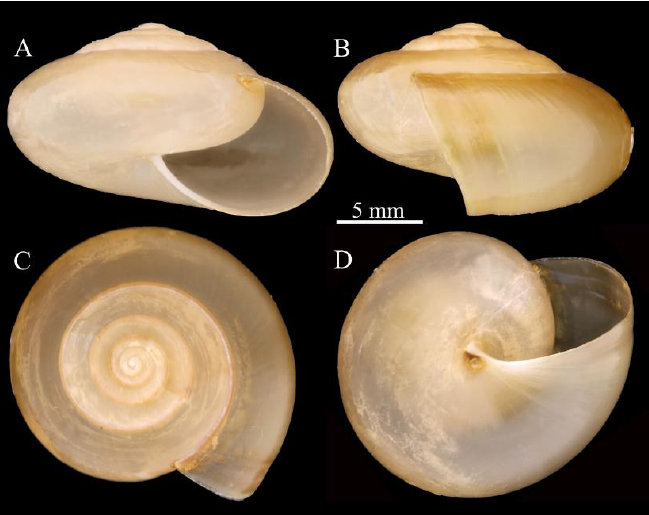
Figure 3. The shell of Macrochlamys indica of SAFN17a specimen collected from Wardet Al-Soltan nursery, Taif, Saudi Arabia in apertural view ( A ), lateral view ( B ), apical view ( C ), and basal view ( D ). Table 3. Morphometric characteristics of Macrochlamys indica.